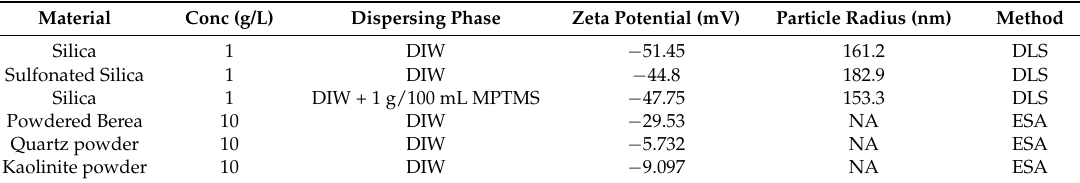
Particle Size and Zeta potential measurements. DIW: Deionized water; MPTMS 3-Mercaptopropyl Trimethoxysilane; NA: Not Applicable; DLS: Dynamic Light Scattering; ESA: